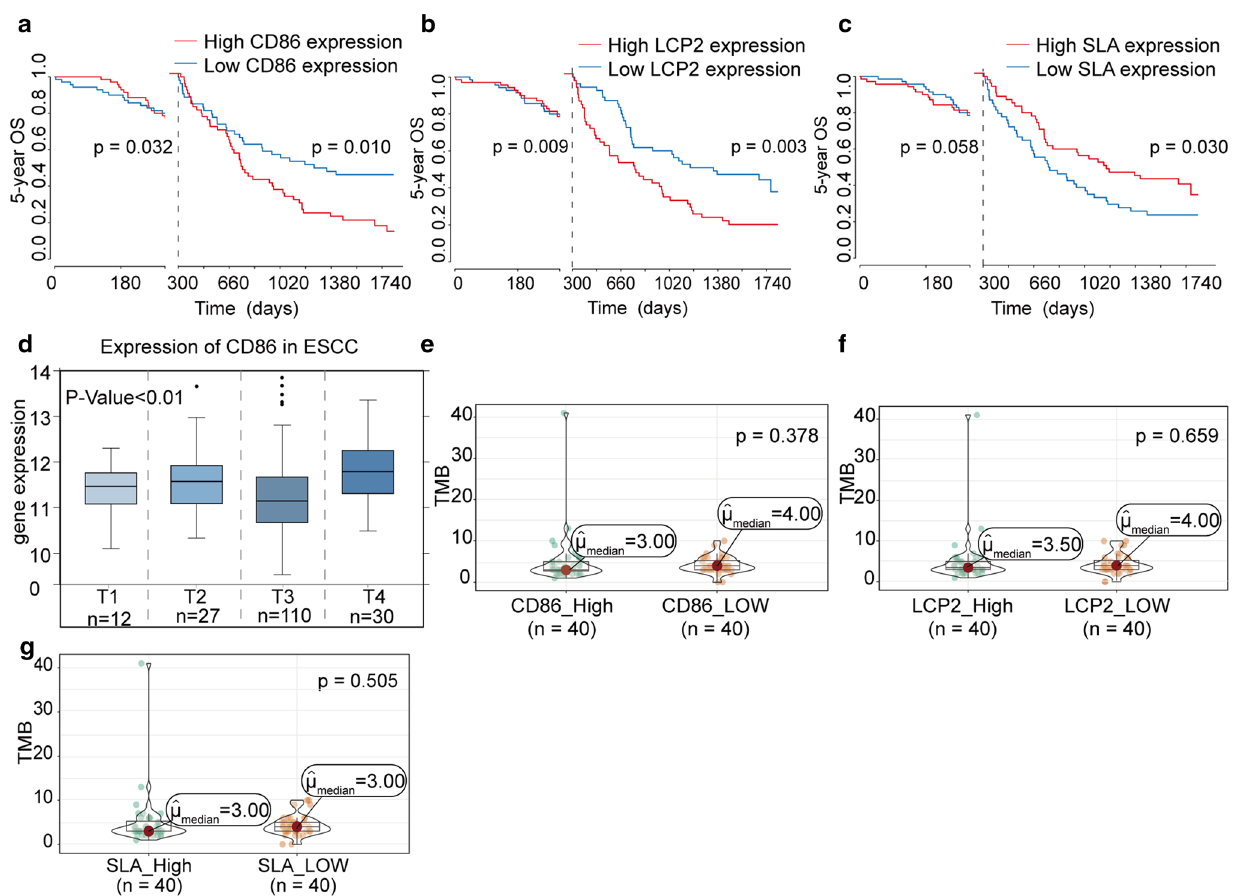
Fig. 8 The Validation for survival and correlation analysis with TMB of three key prognostic genes. a – c Kaplan Meier curves and log rank test were performed for CD86, LCP2 and SLA in independent cohort from GEO database. d The correlation between the expression of CD86 and pathological stage in ESCC patients from GEO database. e – g Correlation analysis between the expression of CD86, LCP2 and SLA and